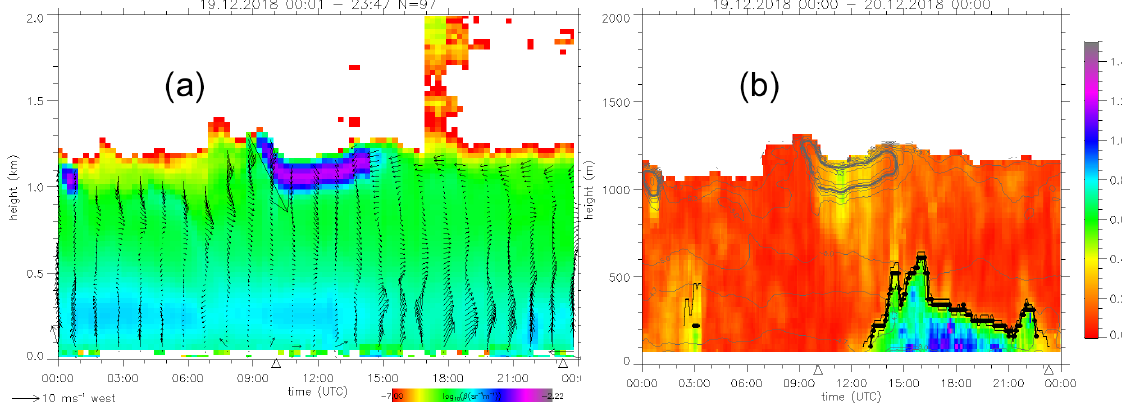
Figure B1. Like Fig. A1 for 19 December 2018.